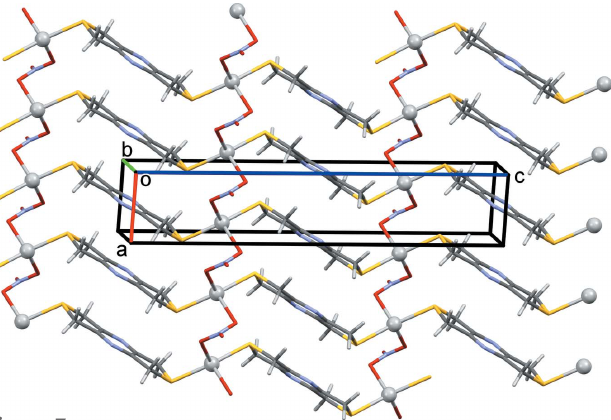
Figure 7 Aview along the b axis of the crystal packing of complex I , illustrating the formation of the metal–organic network. The silver atoms are shown as grey balls. Assoumatine and Stoeckli-Evans (cid:3) New ligands and their coordination polymers